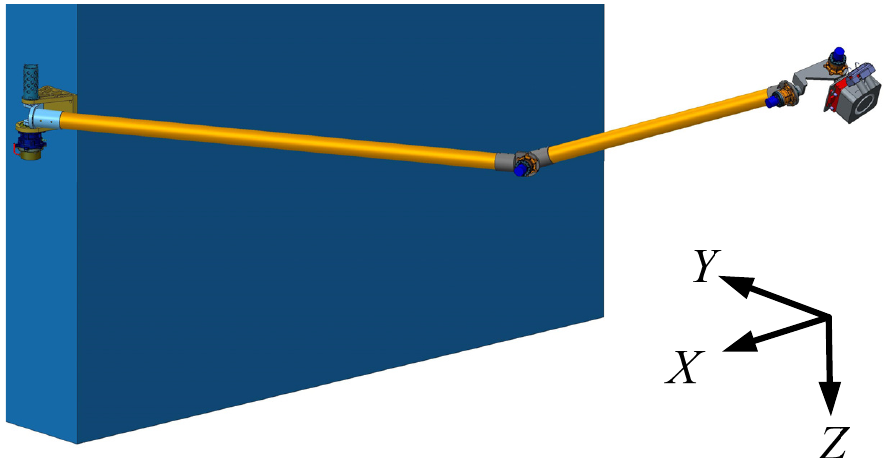
Figure 4. Four-degree-of-freedom manipulator with EP solution.